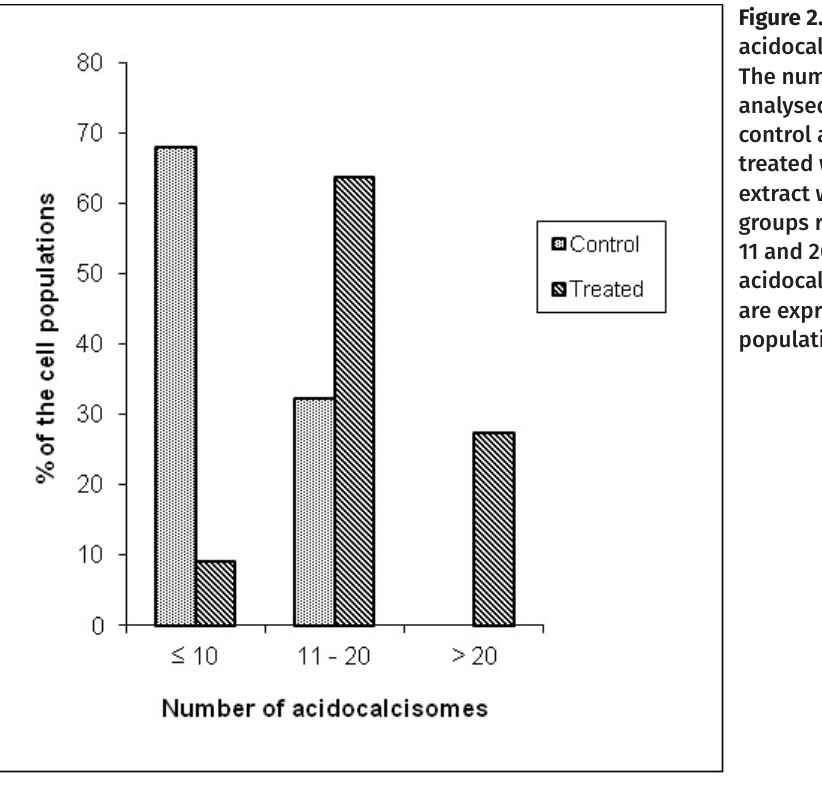
Figure 2. Numeric analysis of the acidocalcisomes in L. amazonensis . The number of the organelles was analysed and compared between control and treated cells. The cells treated with the sponge aqueous extract were subdivided into two groups representing cells between 11 and 20, and more than 20 acidocalcisomes per cell. Results are expressed in percentage of cell populations.